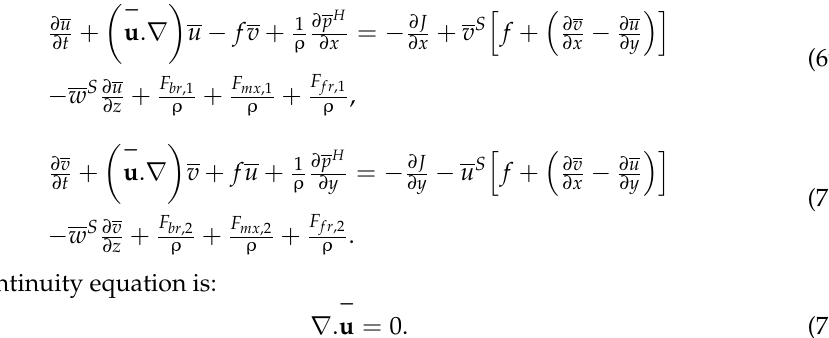
Table 2. Comparison of Bennis, Ardhuin [11] and Nguyen, Jacobsen [5]. Bennis, Ardhuin [11] Nguyen, Jacobsen [5]